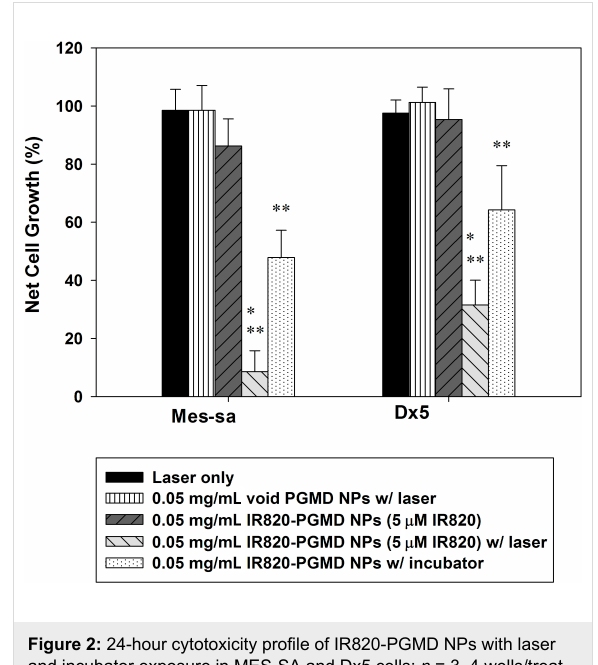
Figure 2: 24-hour cytotoxicity profile of IR820-PGMD NPs with laser and incubator exposure in MES-SA and Dx5 cells; n = 3, 4 wells/treat- ment. * p < 0.05 (by ANOVA) between laser/NP HT and incubator/NP HT, indicating laser/NP HT results in significantly improved cytotoxicity compared to incubator HT. ** p < 0.05 (by ANOVA) between HT and without HT group in both cell lines, indicating significantly higher cancer cell killing was achieved due to